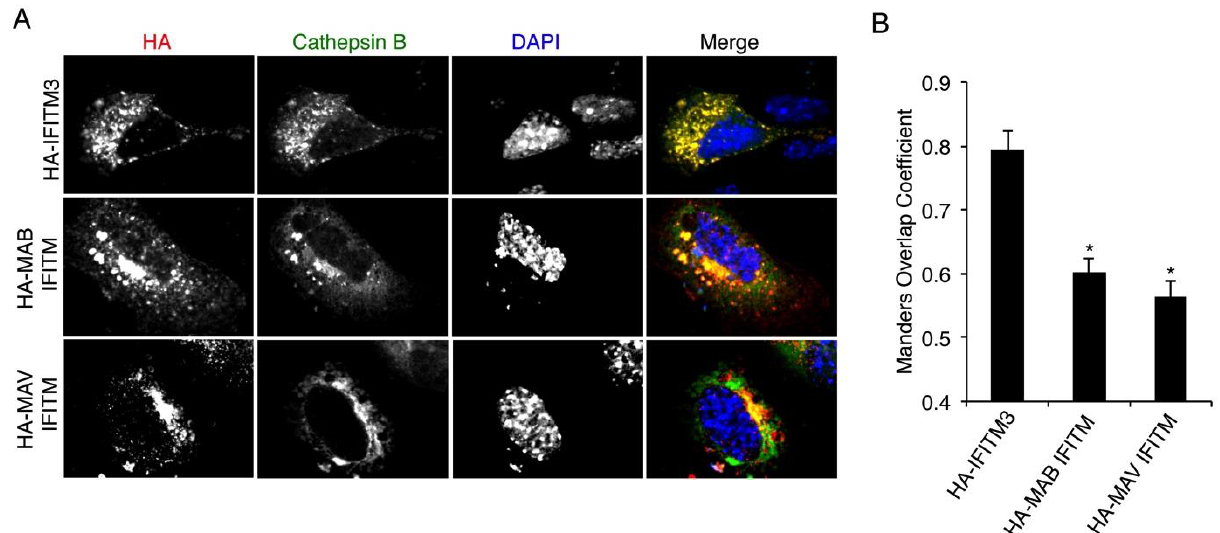
Figure 6. Mycobacterial IFITMs localize to lysosomes less efficiently than IFITM3. ( A , B ) HEK293T cells grown on glass coverslips were transfected with expression